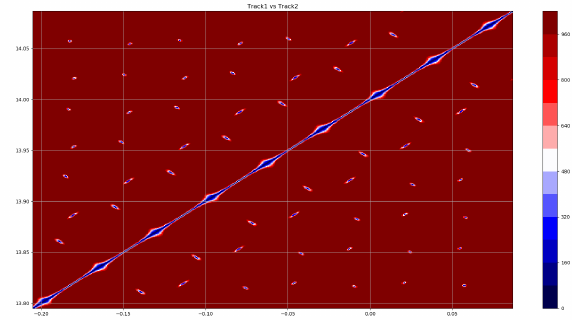
Figure 16. Plot of the positions of the ALOS-2 satellite in the first acquisition versus the second acquisition